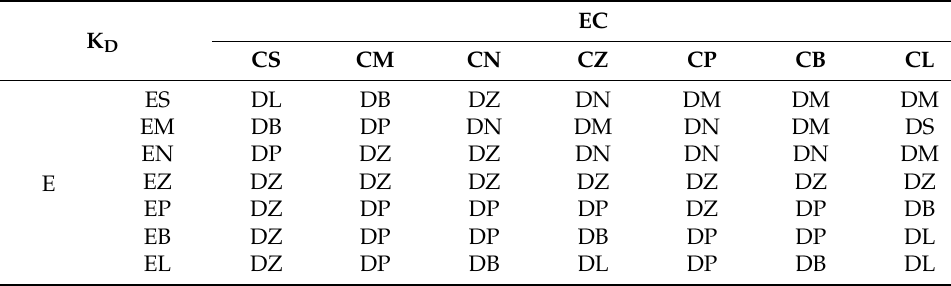
Table 3. Fuzzy rule table of control parameter K D .